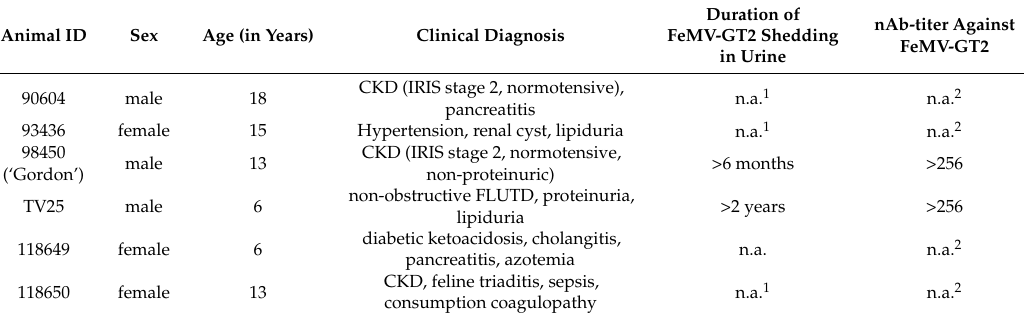
Table 1. Characteristics of FeMV-GT2-positive